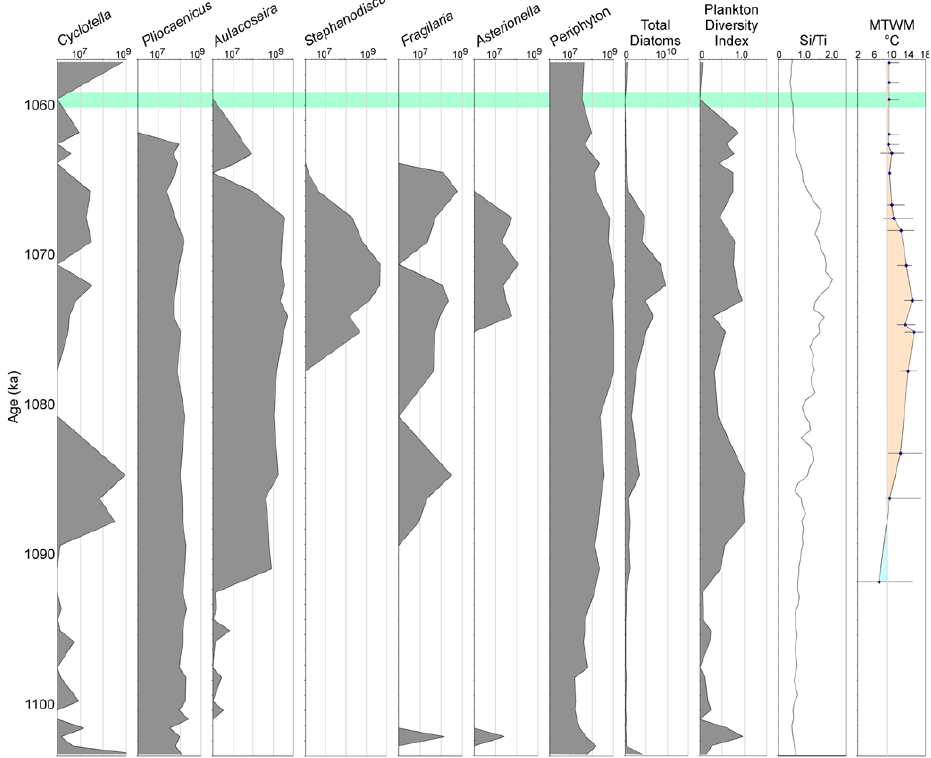
Fig. 6. Concentration (valves g − 1 ) of planktonic species, total periphyton, total diatoms, and plankton diversity (Shannon index) from 1057 to 1103ka. Other El’gygytgyn climate proxies from Melles et al. (2012) are included for comparison (see Fig. 3). The green bar indicates a sparse plankton event (compare Fig. 2) not observed in lower-resolution